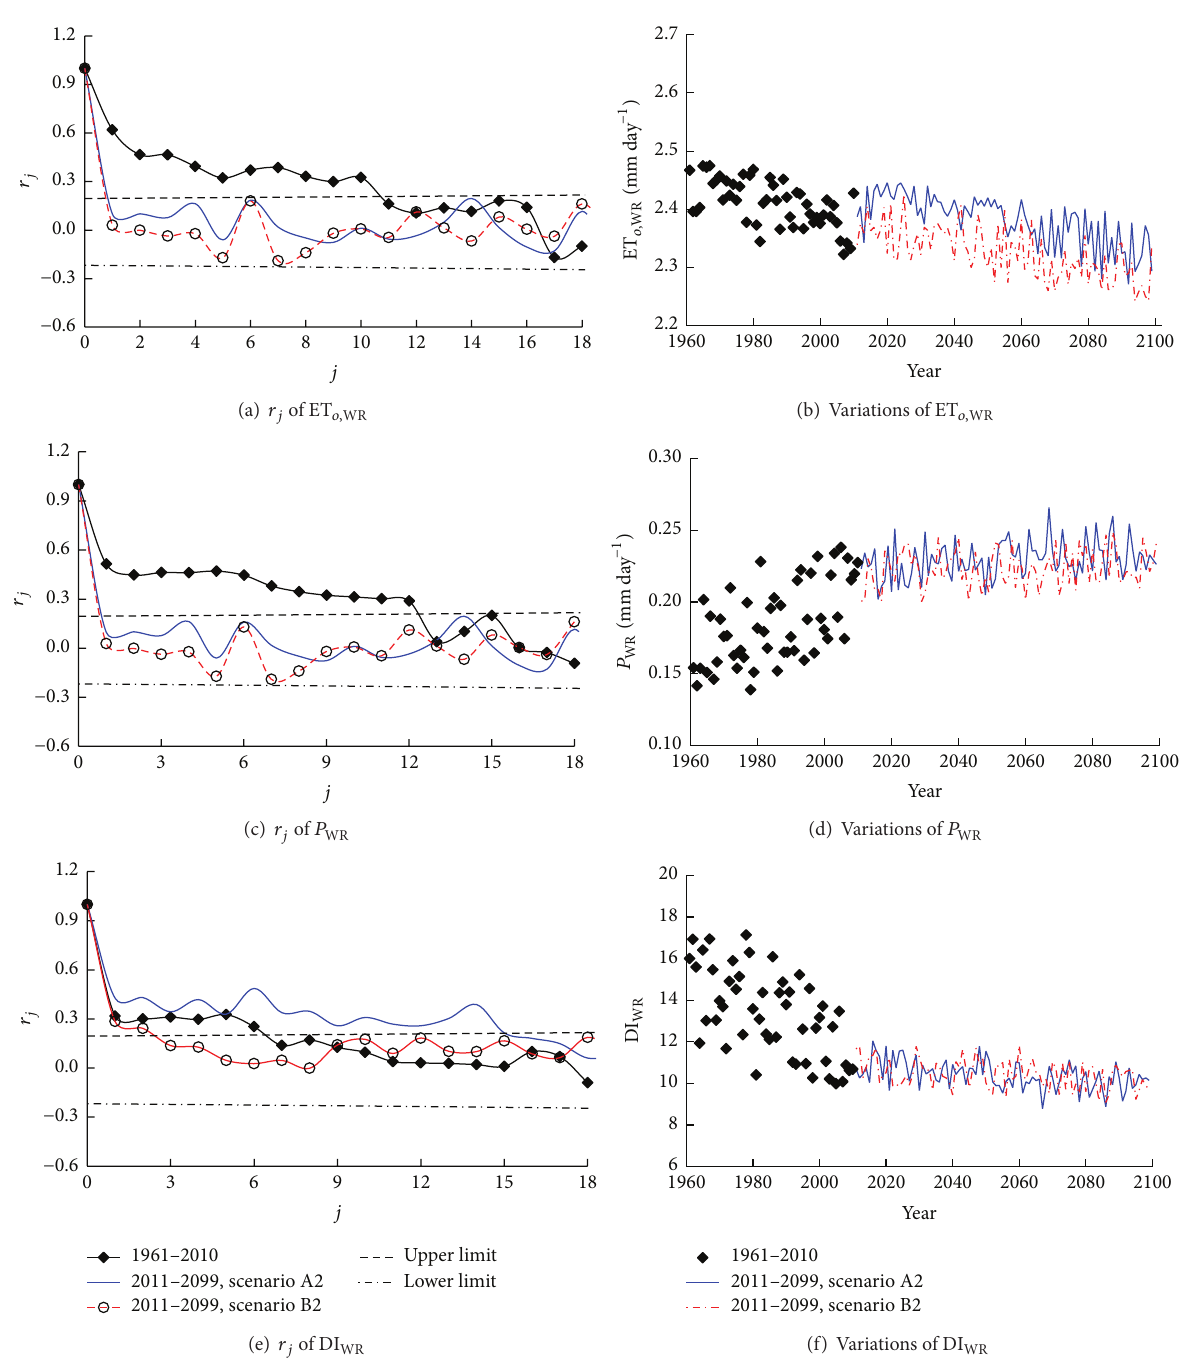
Figure 5: Variations of ET 𝑜,